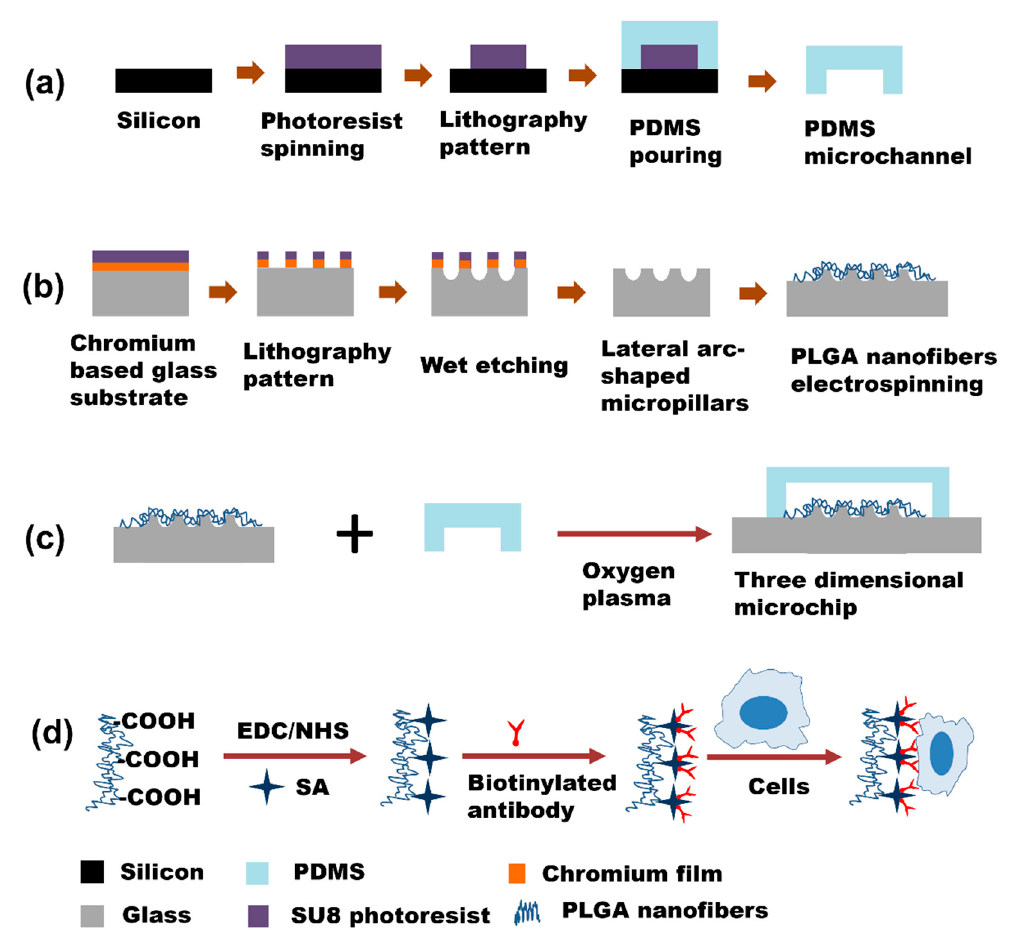
Figure 1. ( a ) PDMS microchannel fabrication. ( b ) Wet etching of lateral arc-shaped micropillars coupled with PLGA nanofibers. ( c ) PDMS microchannel was bound to substrate by oxygen plasma. ( d ) Specific antibody chemical modification on PLGA nanofibers.